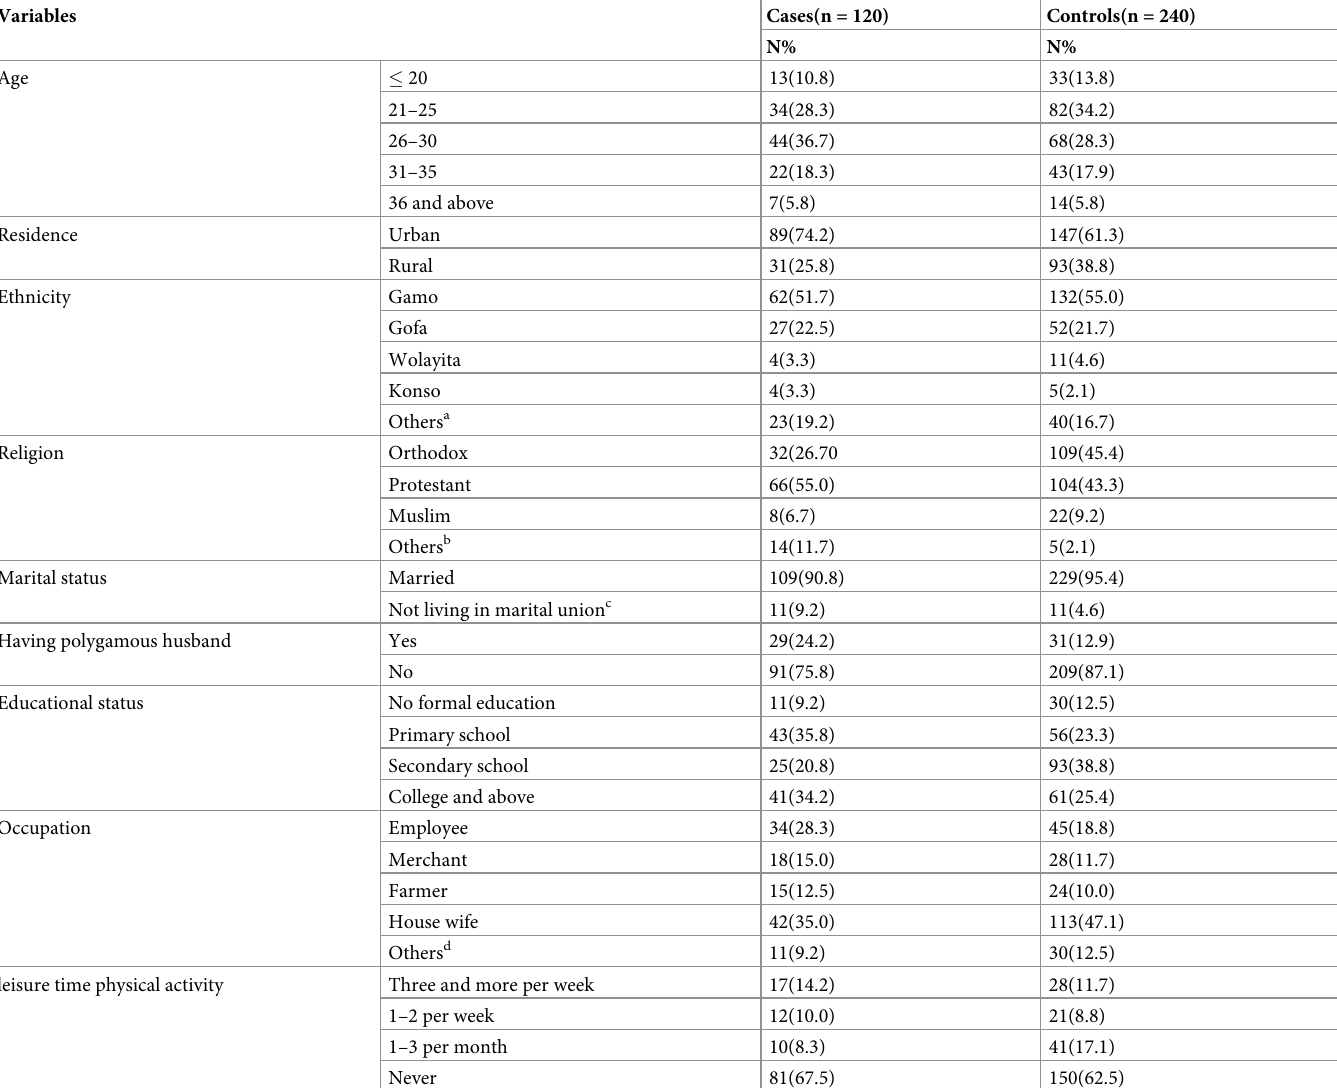
Table 1. The socio-economic characteristics of pregnant women attending health care service in public hospitals, southern Ethiopia,